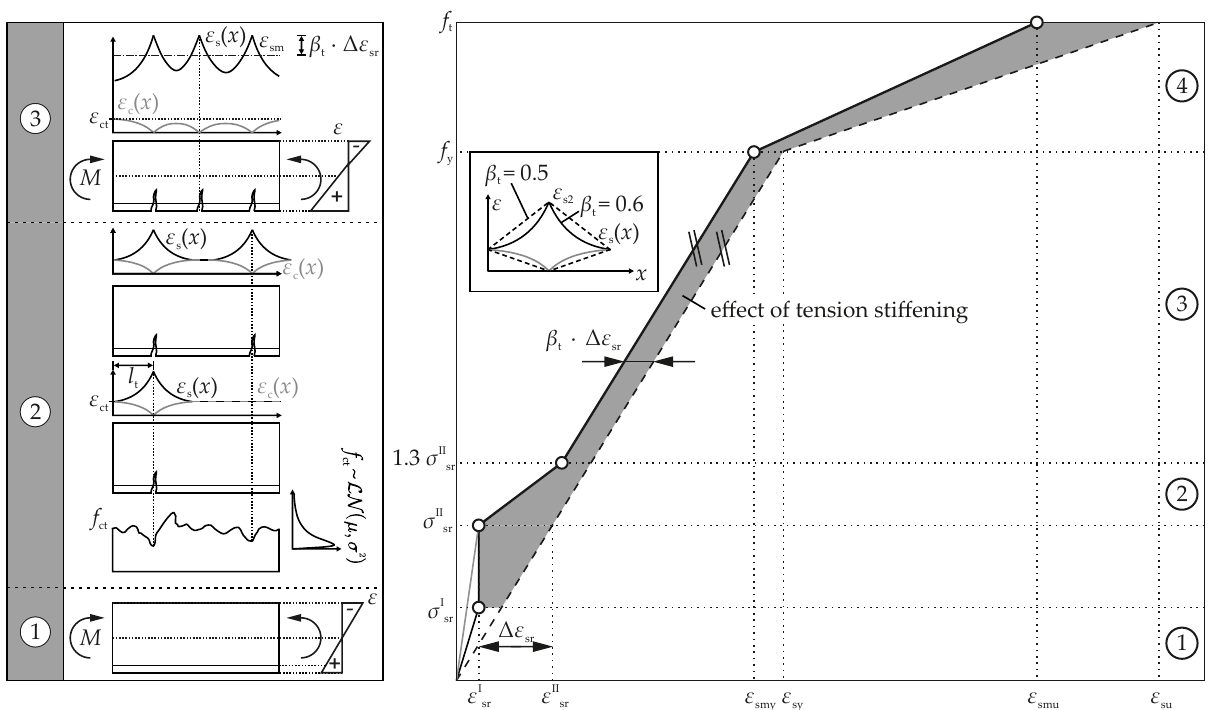
Figure 3. Concrete and steel strains ( left ) for the three ranges of the σ s - ε sm -relation ( right